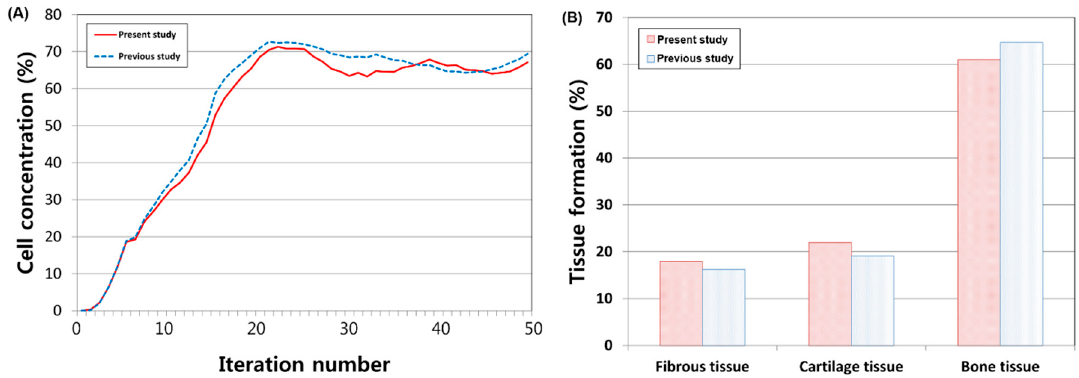
Figure 4. Comparison of prediction of ( a ) cell concentration at the articular surface and ( b ) percentage of tissue types between this study and a previous study [9] for validation.